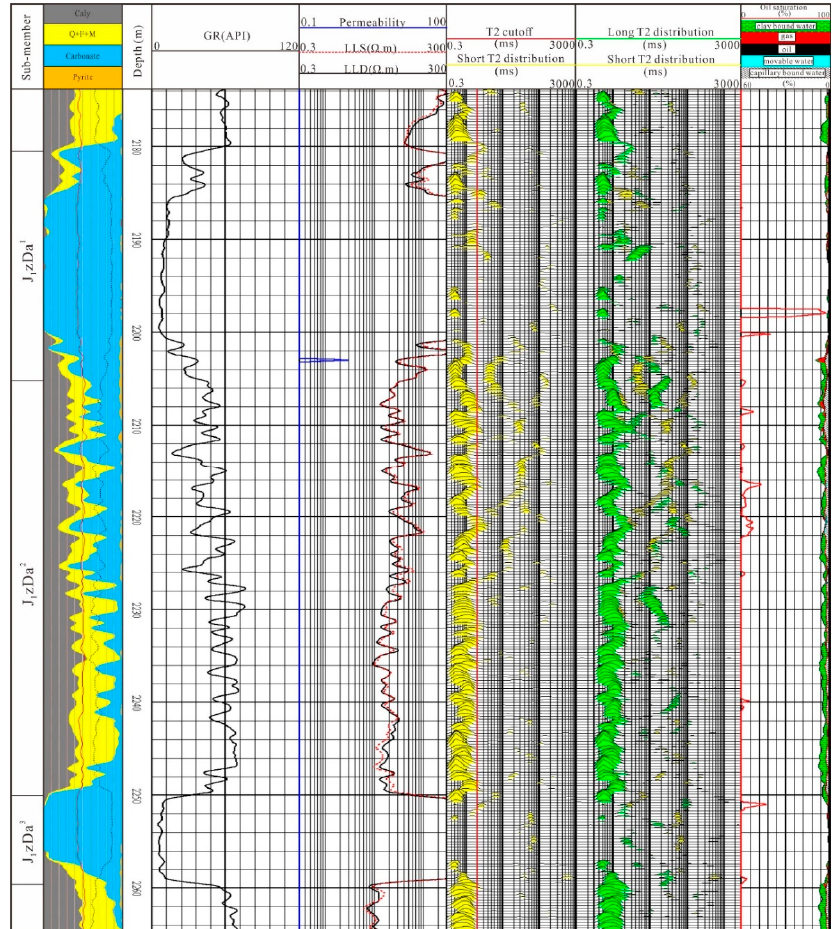
Figure 8. The reservoir evaluation from NMR logging data in the Da’anzhai member, well FY3-2. Table 2. The reservoir evaluation results of five types of shale lithofacies in the Da’anzhai member from NMR well logging data.